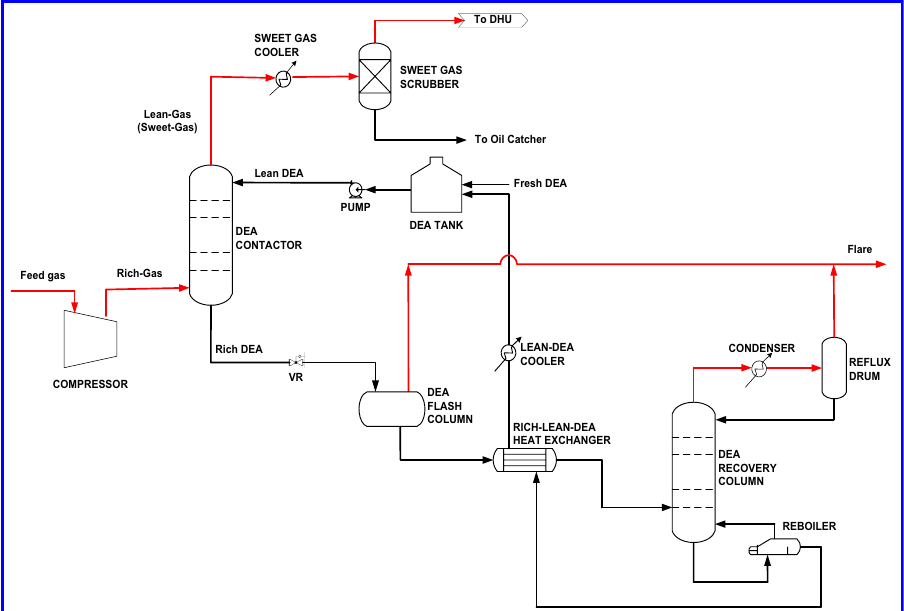
Fig. 7 PFD of contactor amine